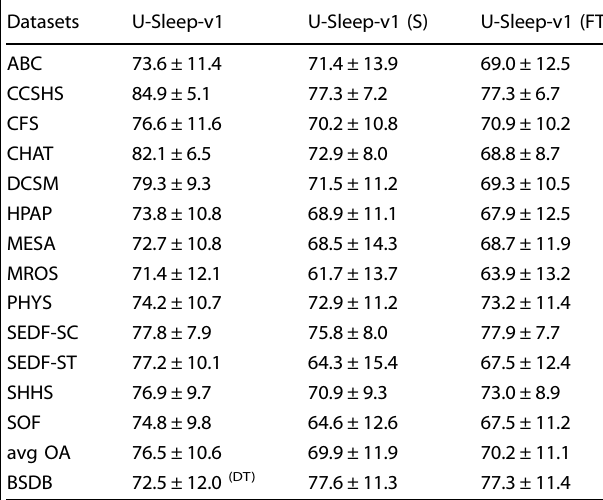
Table 3. (ii) Generalizability on different data centers with a heterogeneous